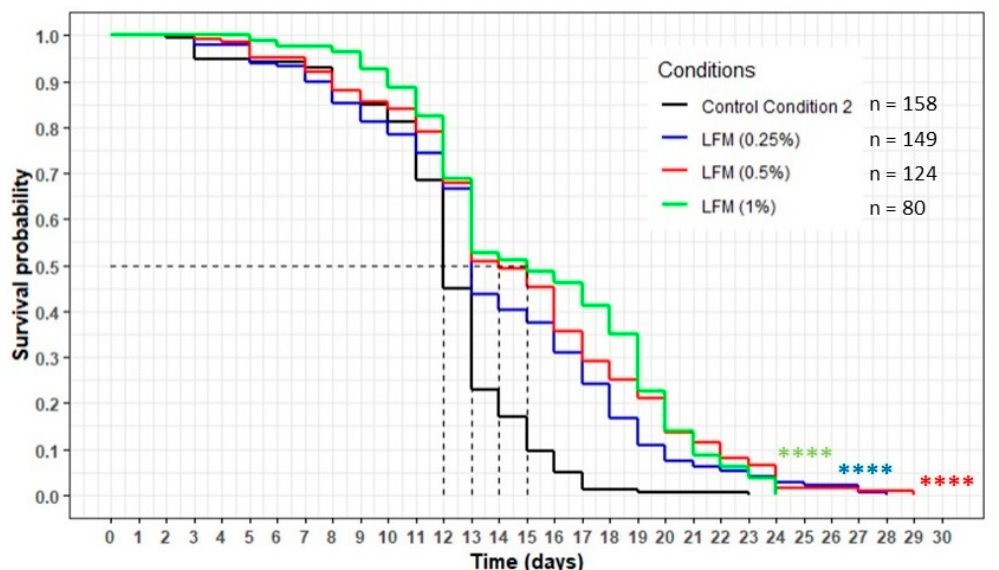
Figure 11. The influence of the LFM (lipid-free milk) on the lifespan of the wild-type C. elegans N2 strain. The worms were incubated on the medium supplemented with the dried extract at day 0 and regularly fed with HK E. coli OP50. The conditions were considered significantly different from the control conditions CC2 when the p -value was lower than 0.0001 (****) (log-rank test). Table 8. Data of the longevity assay of the wild-type C. elegans N2 strain on the medium supplemented with the LFM (lipid-free milk) and CC2 as a control. Mean lifespan, maximum lifespan and the percentage of population still alive are from survival curves. p -values were calculated by comparing conditions with CC2 using the log-rank test.